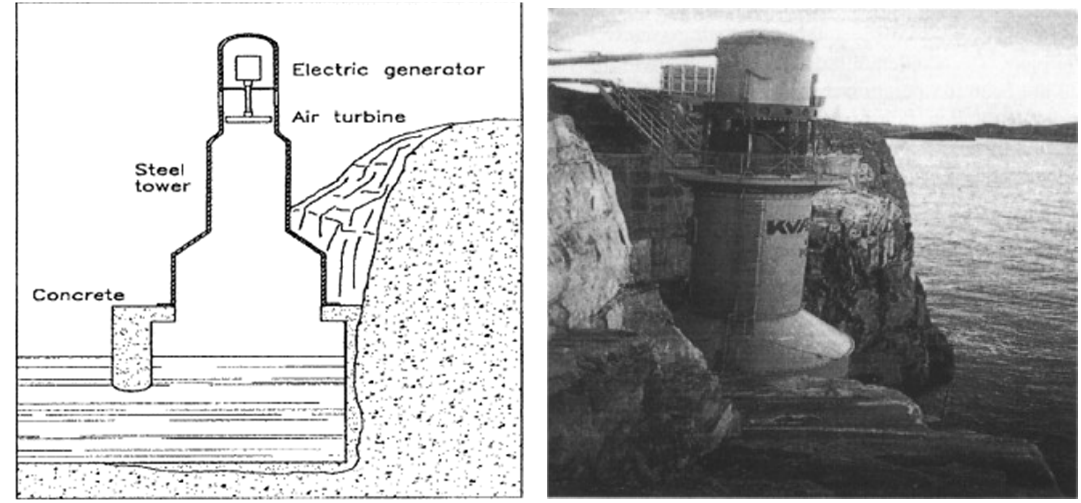
Figure 8. Sectional drawing (left) and view (right) of the Kværner Brug’s OWC plant (reproduced with permission 5139250049270 from [42], Elsevier, 2003).